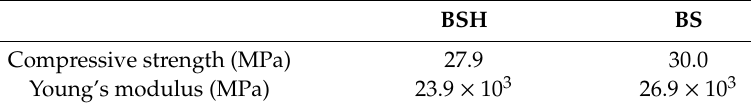
Table 2. Concrete properties.